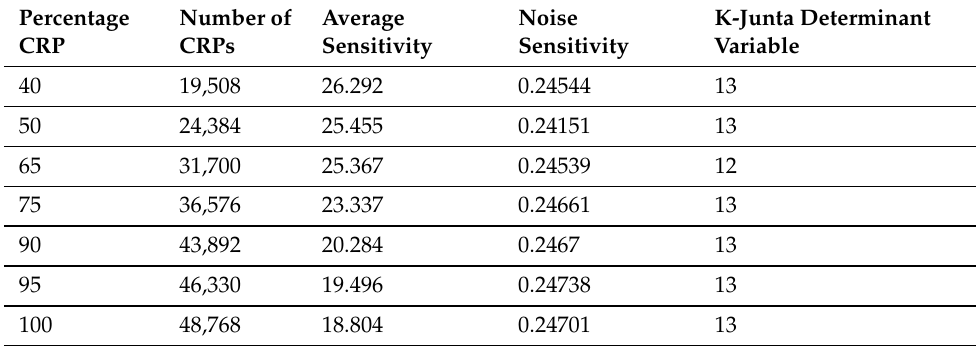
Table 5. PUFmeter test results on the resiliency of the RESA authentication